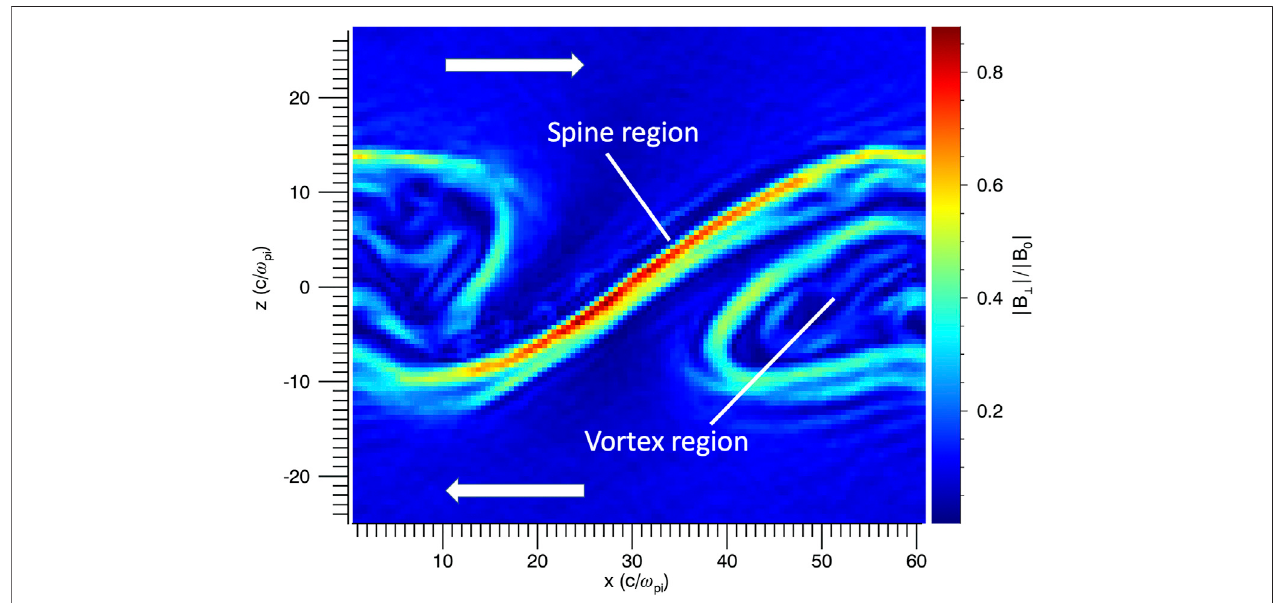
FIGURE 5| Structure of a KH vortex as illustrated with the magnitude ofthe in-plane magnetic fi eld. The spine region connectsadjacent vortices and is a barrier to fl ow due to the accumulation of magnetic fl